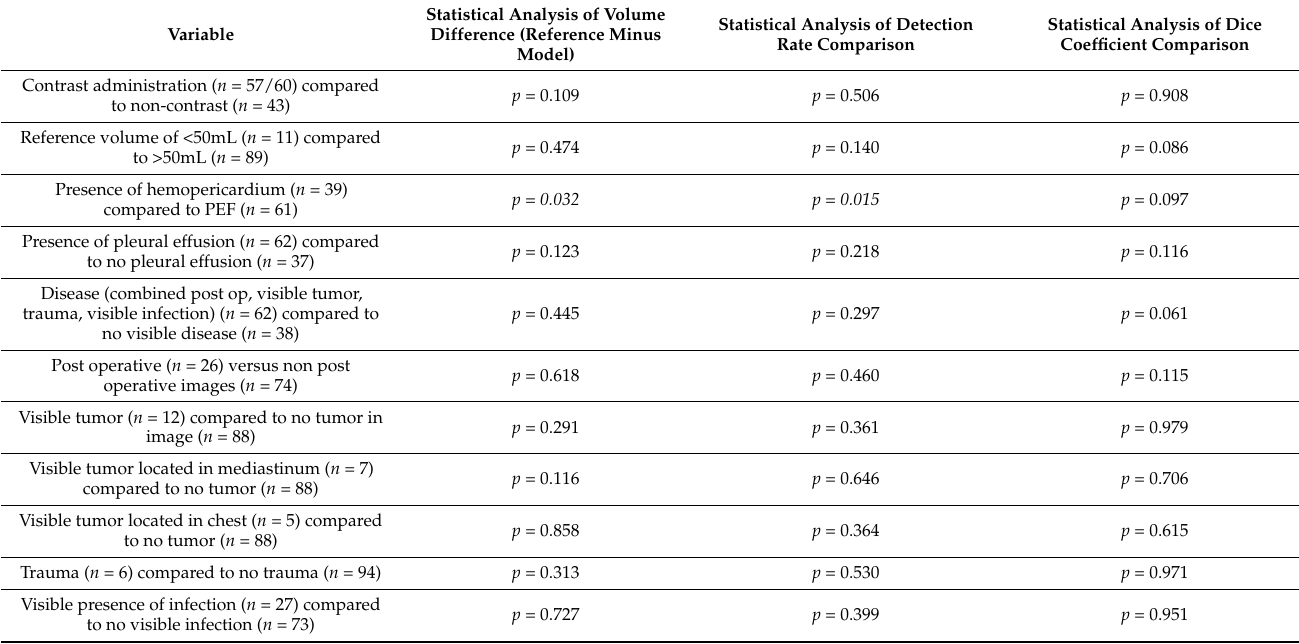
Table A1. The effects of confounding factors on model